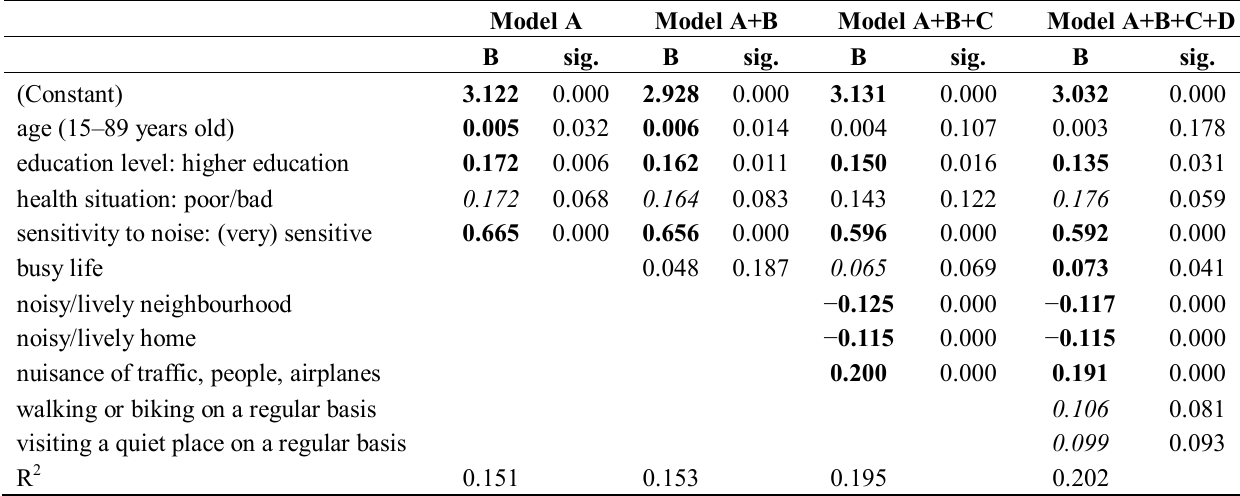
Table 1. The need for quietness in and around the home and in the neighbourhood (N = 809), multiple linear regression 1